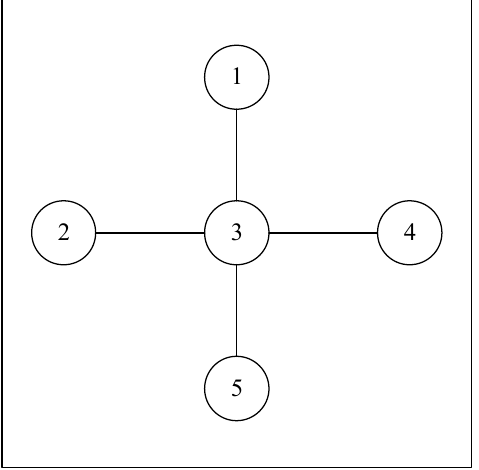
Figure 1. An online social network with 5 individuals.